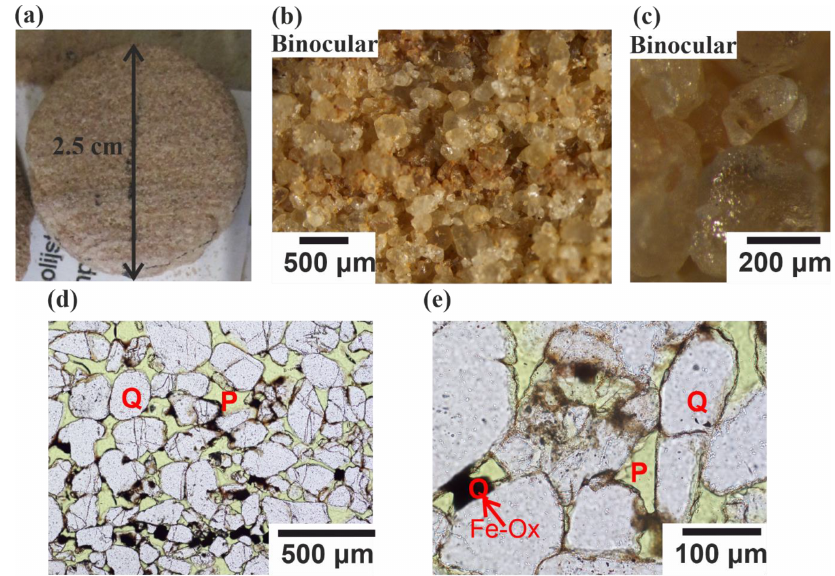
Figure 5. Representative images of sandstone S3. (a) Laminae are recognized by their slightly dark and red colour. (b) General view reveals red laminae ∼ 300µm thick. (c) High-resolution observation of a clear grain. (d) A millimetre-scale lamina is indicated by enhanced meniscus-type FeOx cementation and partly by intergranular fill. Grain surfaces are coated by thin FeOx. Black and orange cements represent crystallized and non-crystallized FeOx, respectively. Some cracked grains are observed, sporadically cemented by FeOx. P refers to open pores, Q to quartz. (e) Partially dissolved grains are coated by cement.